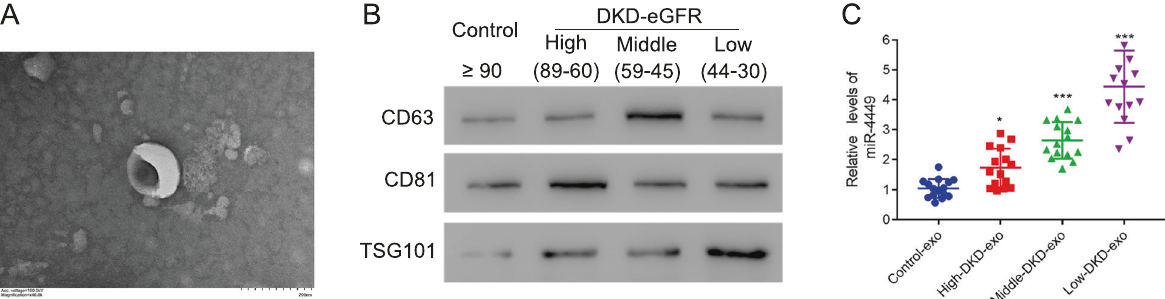
Fig. 1 miR-4449 is upregulated in serum exosomes of patients with DKD. Patients with DKD were divided into three groups ( n = 15 for each group) using the eGFR scoring method: high DKD (score: 89 – 60), middle DKD (score: 59 – 45), and low DKD (score: 59 – 45). Exosomes were isolated from the serum of the patients. A The structure of the exosomes was imaged with transmission electron microscopy (TEM). B Protein levels of exosome markers from patients with different degrees of DKD were examined with Western blotting using the indicated antibodies. C The miR-4449 levels in different DKD exosomes were determined using RT-PCR. * P < 0.05 vs. Control-exo, *** P < 0.001 vs. Control-exo.